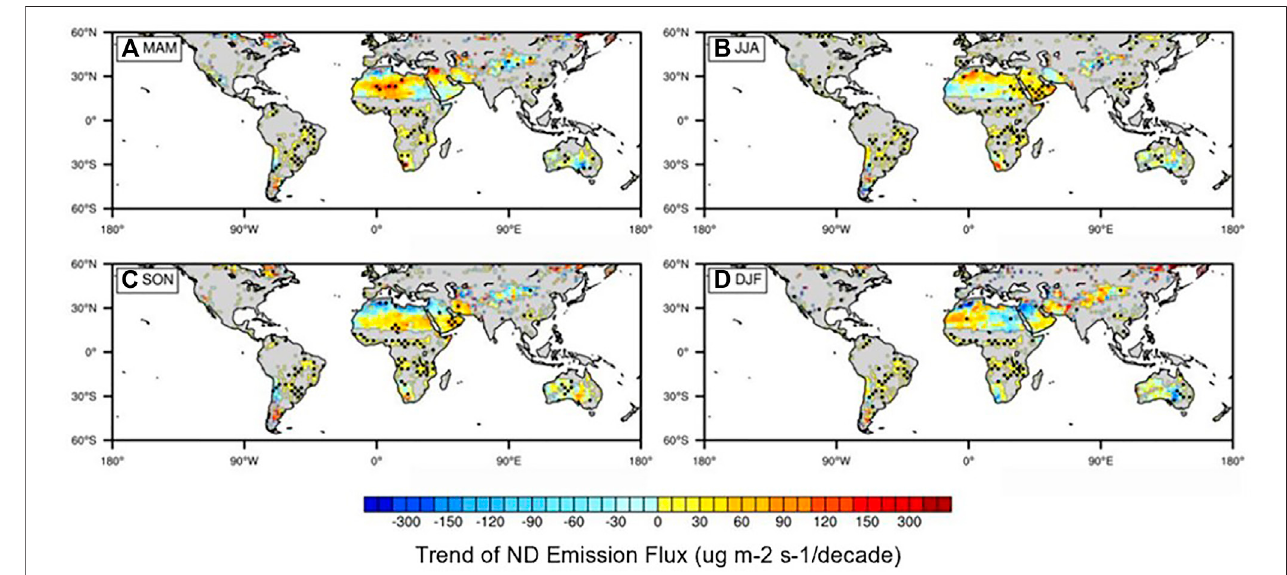
FIGURE 11 | Same as Figure 5 of trend of the AD emission fl ux (units: μ g m − 2 s − 1 /decade).